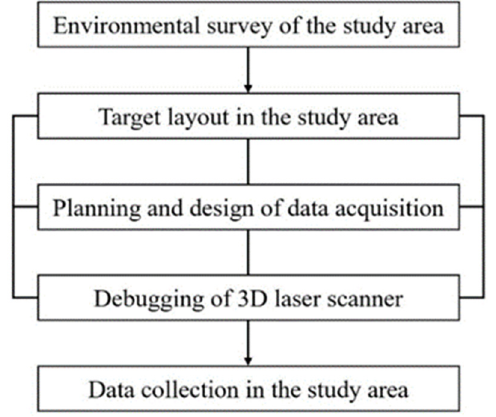
Figure 4. Flow chart of 3D laser data acquisition.